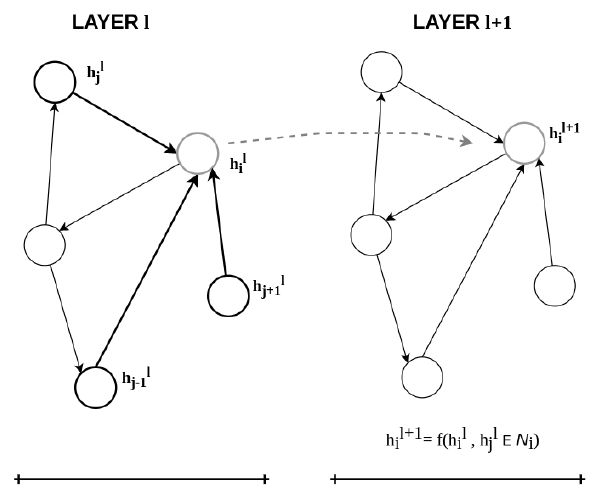
Figure 4. GNN basic message passing